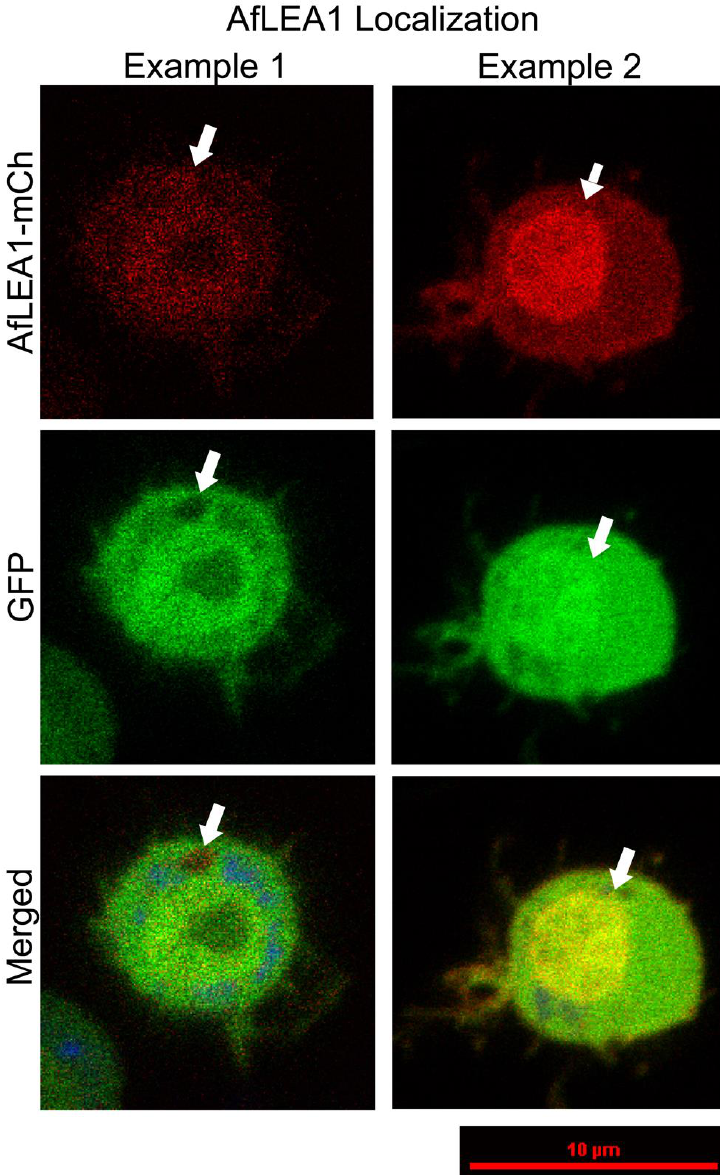
Figure 12. A chimeric protein composed of Af LEA1 and mCherry localizes predominately to the cytoplasm in D. melanogaster Kc167 cells ectopically co-expressing Af LEA1-mCherry and GFP (Ex- amples 1 and 2). In some cells, Af LEA1-mCherry was also observed to undergo an LLPS and exclude GFP from the biomolecular condensate (Example 1). Af LEA1-mCherry was observed to accumulate in the nucleus of other cells (Example 2). Cells were stained with 200 µL of MitoView Blue, and Af LEA1-mCherry does not localize to the mitochondria. Images are representative images, and flu- orescence intensities are not relative between examples (for a quantitative assessment, see Figure S3, Supplementary Materials).